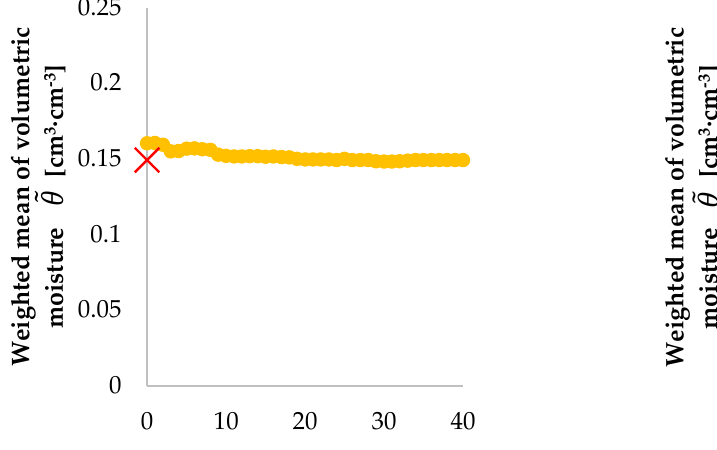
Figure 10. Evaporation versus weighted mean of volumetric moisture after the injection dose of 750 cm 3 at depths of 5, 10, and 15 cm.